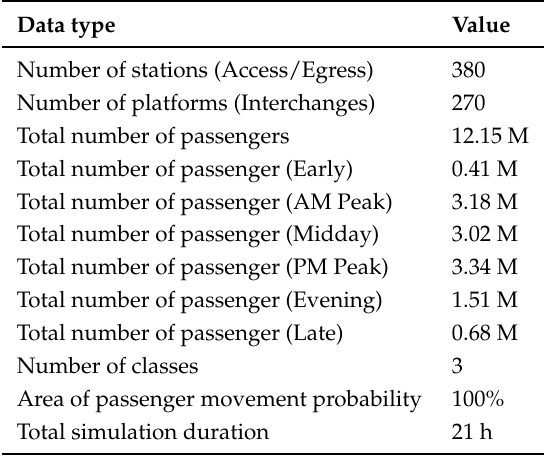
Table 1. Simulation scenario and settings (M = millions, h =